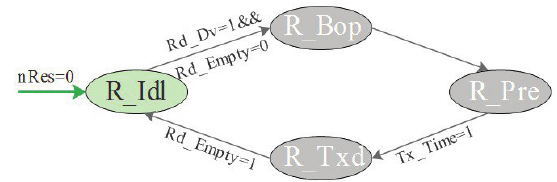
Fig. 6. State Automata of Rx Block.